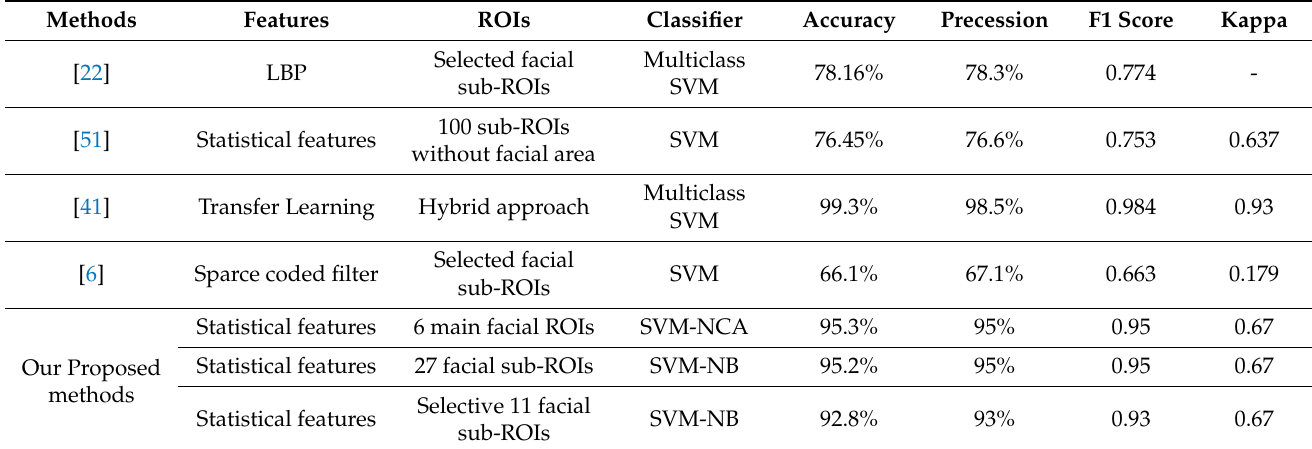
Table 7 . Comparative results with other literature studies based on USTC-NVIE database.